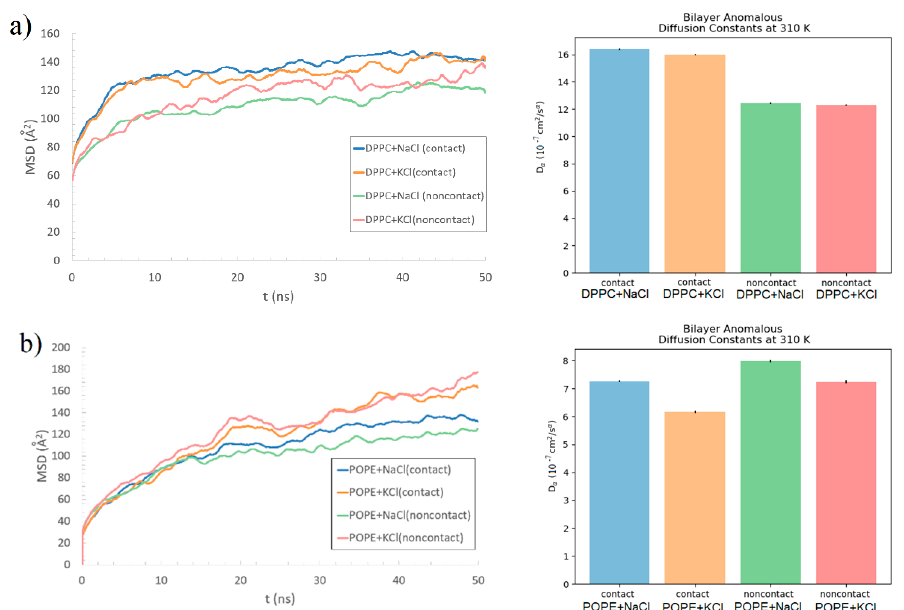
Figure 11. Evolution of the MSD of the lipids in time (left) and fitting values of diffusion coefficient D α (right) for two lipid bilayers: ( a ) DPPC and ( b ) POPE, averaged over all lipid molecules for all iterations of the simulation. Black lines on the bar graph show the standard deviation (STD) of the fitting parameters. All results were obtained for the bilayers with the presence of the protein bound to it.